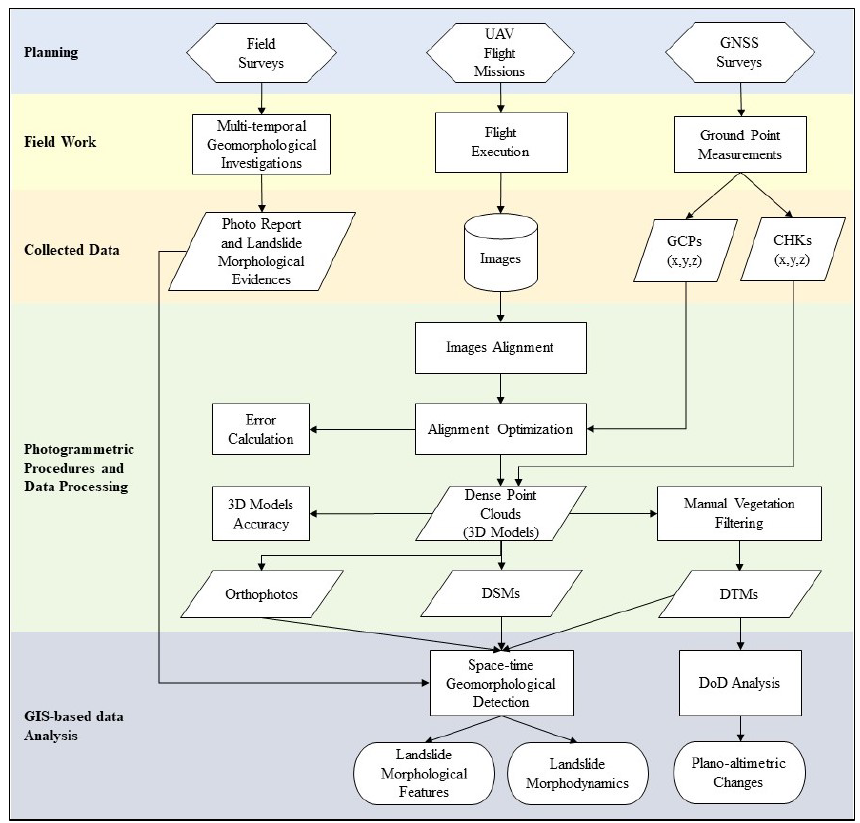
Figure 3. Flow chart of the methodology used to assess the evolution of the Vomice landslide.